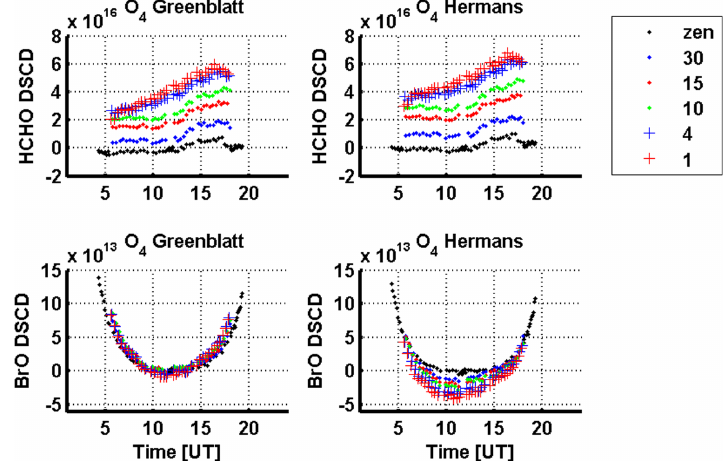
Fig. 13. Effect of the choice of the O 4 cross section used in the DOAS fit, on HCHO and BrO DSCD columns (moleccm − 2 ). Results (a) and (c) are obtained with the Greenblatt et al. (1990) cross sections while (b) and (d) are obtained using the Hermans et al. (2003) cross sections.